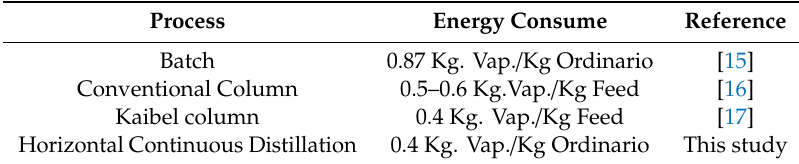
Table 3. Energy consumption of the di ff erent distillation